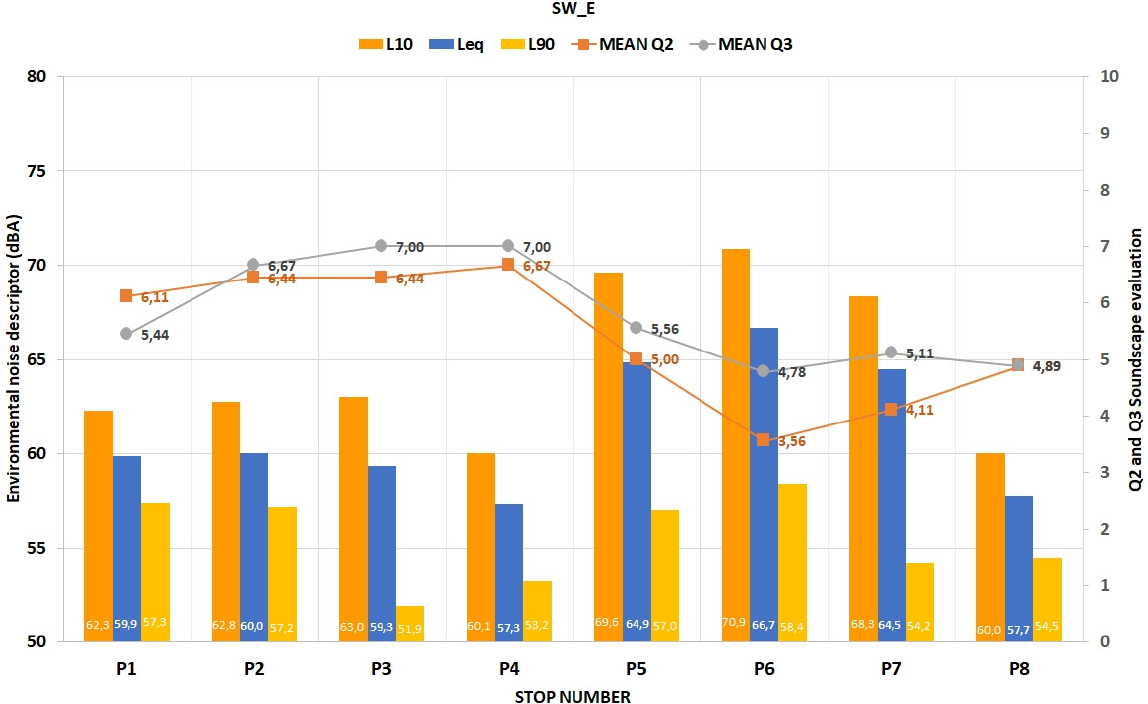
Figure 9: Mean Q2 and Q3 responses and coincident environmental noise characterisation (using Leq, L10 and L90) at different stop sites during